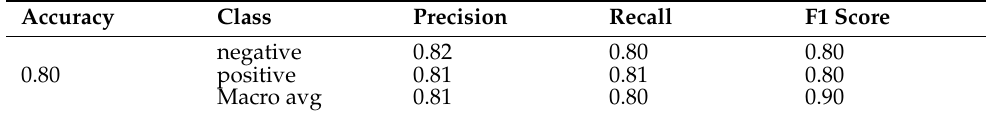
Figure 3. Performance comparison of ML models using three different feature extraction techniques. Table 10. Experimental results of LR-LSTM with original sentiments.